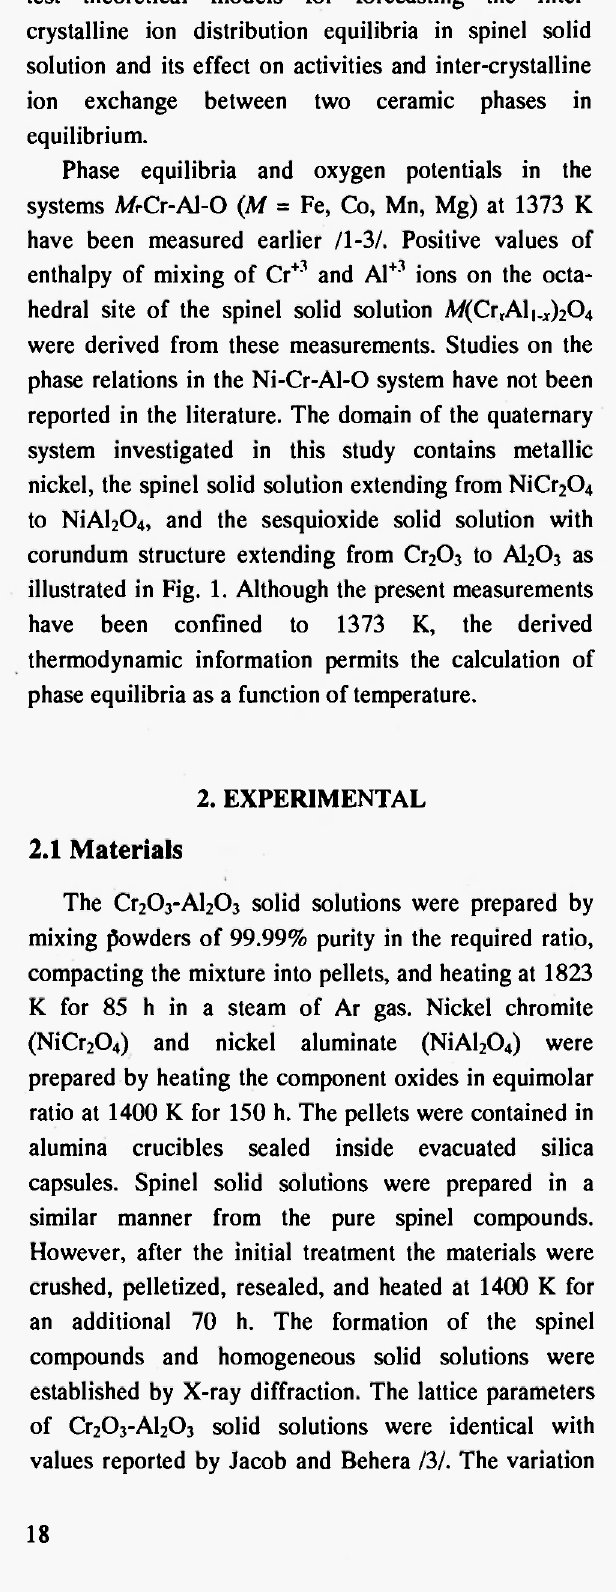
Fig. 1: Sub-solidus phase relations in quaternary system Ni-Cr-Al-0 at constant temperature, indicating the region bounded by Ni, Cr 2 0 3 - A1 2 0 3 corundum solid solution, NiCr 2 0 4 - NiAl 2 0 4 spinel solid solution investigated in this study.